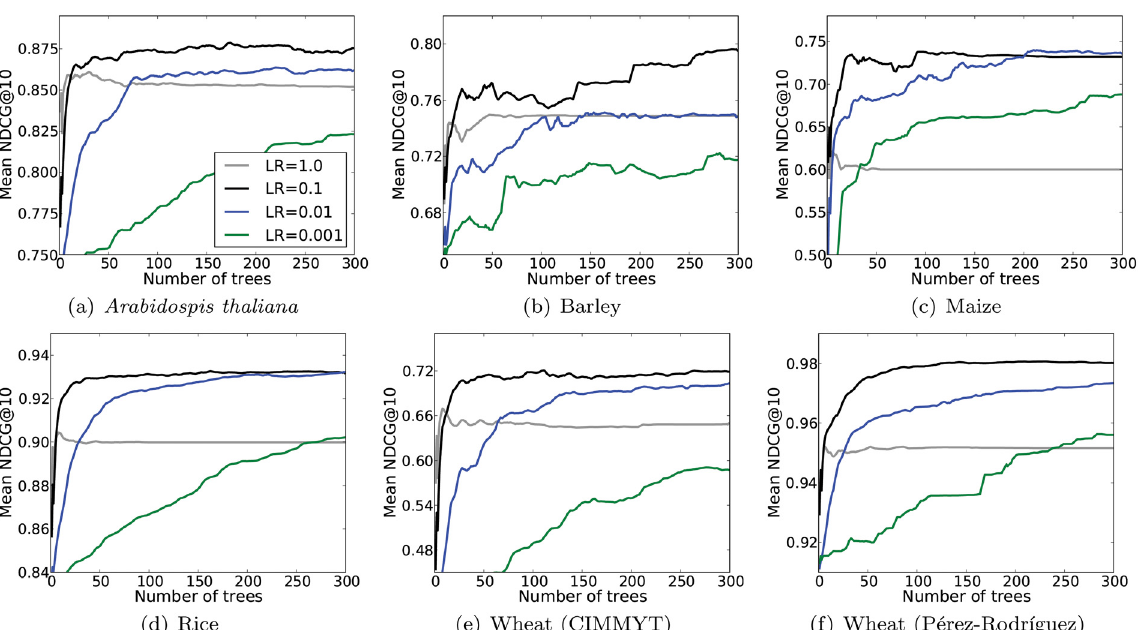
Fig 2. Effect of the learning rate (LR) parameter on GBRT when varying the number of trees. The scores indicated are the test Mean NDCG@10 averaged over 10 CV iterations and across all traits.